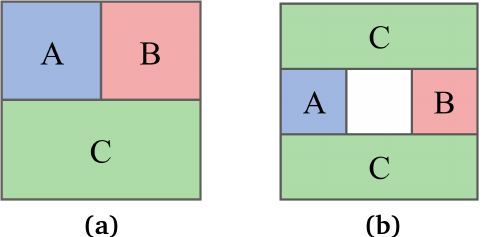
Figure 1: (a) Square I ( A ; B ; C ) and (b) annular I ( A ; B | C ) schemes to isolate topological entanglement entropy in